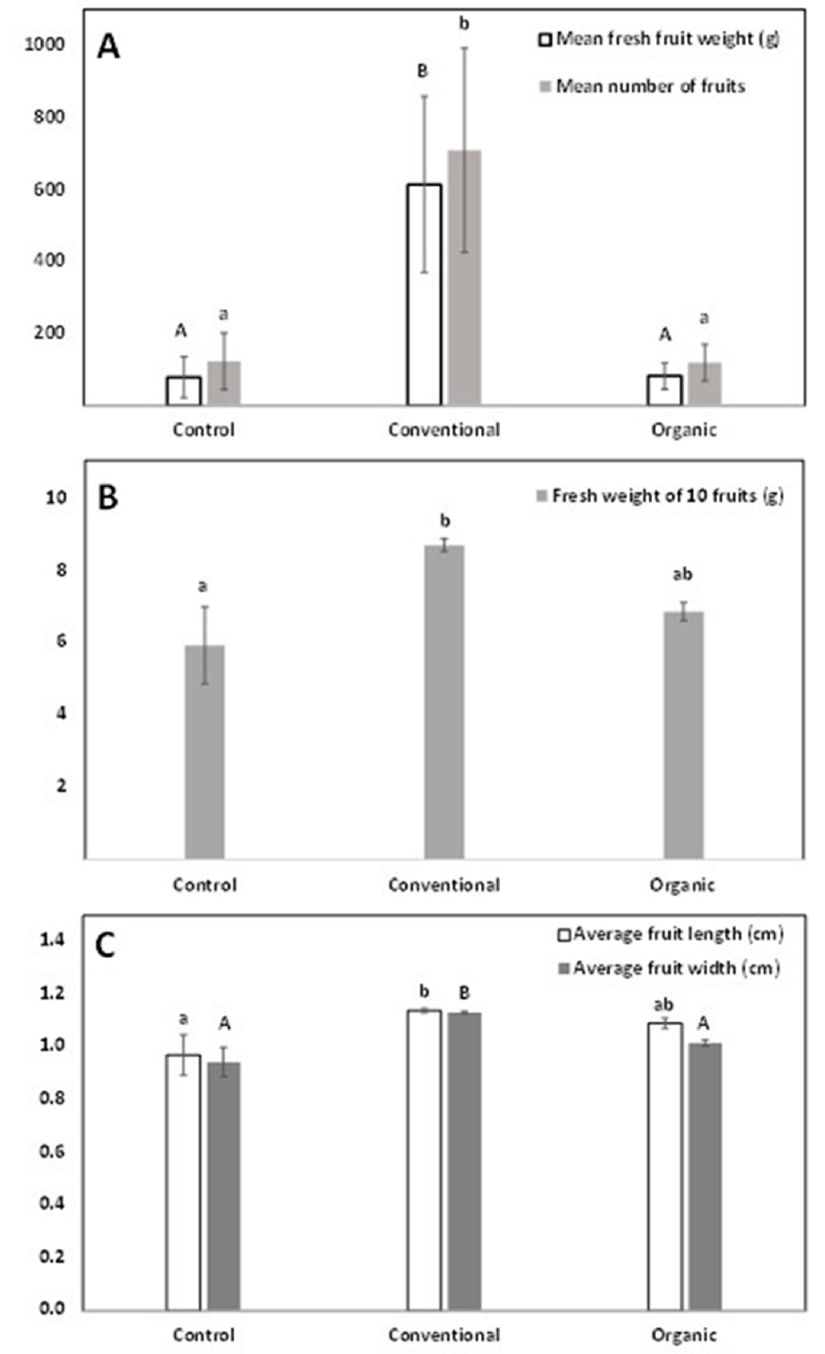
Figure 3. Fruit yield and morphometric data for Amelanchier ovalis subsp. ovalis genotype GR-1- BBGK-04,2547 during the 2022 pilot field trial for the three fertilization treatments applied (control, conventional, and organic). ( A ) Mean fresh fruit weight and mean number of fruits per treatment. Bars that do not share the same label letter are significantly different (Tukey’s HSD, p < 0.05); capital letters for fruit number, and lowercase letters for fruit fresh weight. ( B ) Mean fresh weight of ten randomly sampled fruits for each fertilization treatment. Bars that do not share the same label letter are significantly different (Tukey’s HSD, p < 0.05). ( C ) Average fruit length (cm) and average fruit width (cm) for each fertilization treatment. Bars that do not share the same label letter are significantly different (Tukey’s HSD, p < 0.05); capital letters for fruit width, and lowercase letters for fruit length. Standard errors of the means are shown on all graphs ( p <